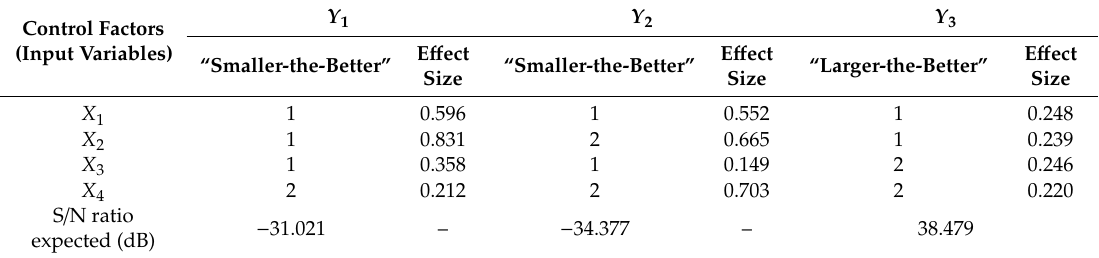
Table 6. Optimal combinations of input variables coded levels, their e ff ect size on the S / N ratio for the system responses, the expected and observed S / N